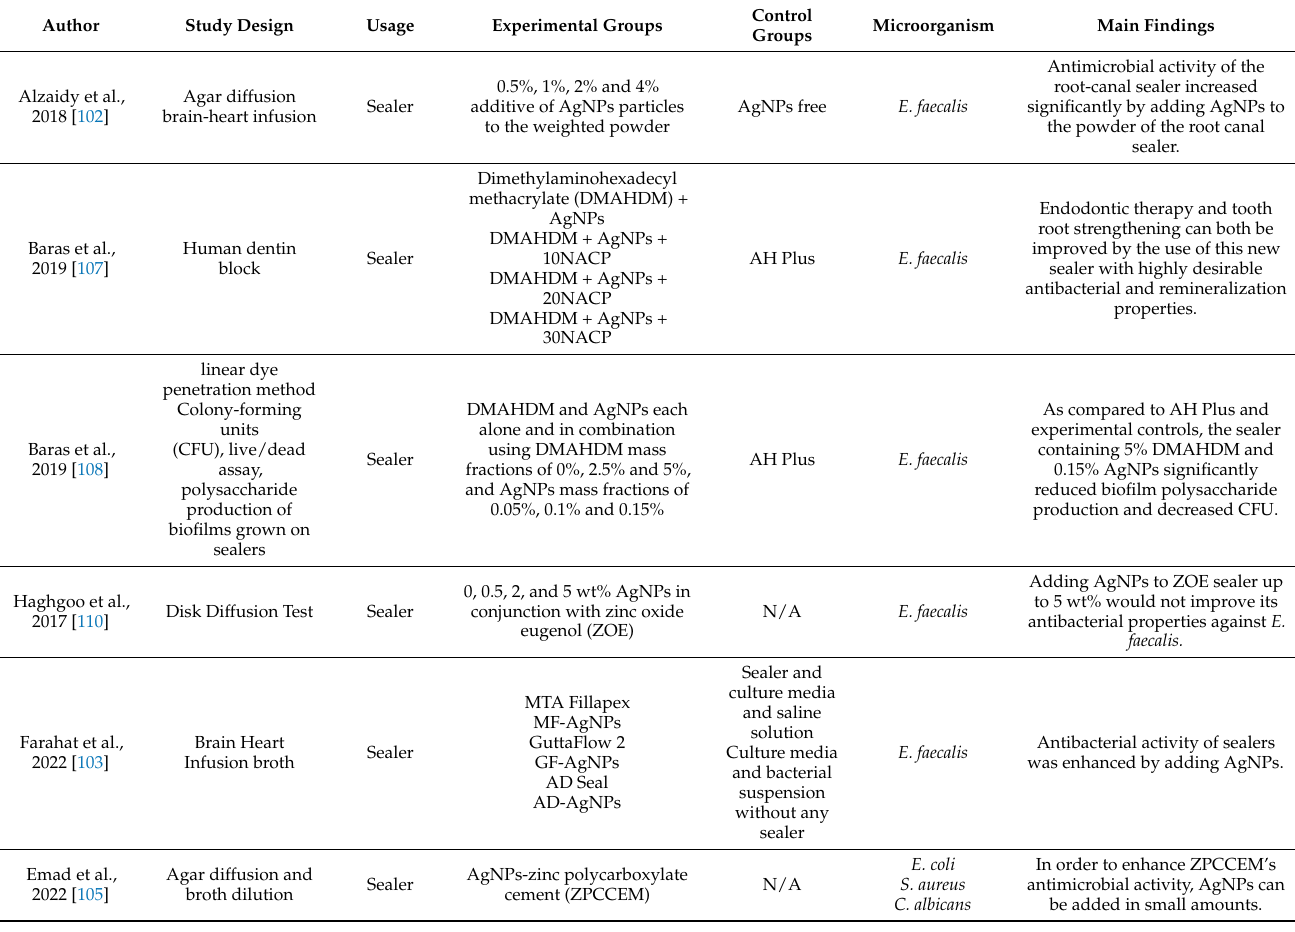
Table 4. Studies of alternative antimicrobial filling materials highlighting antimicrobial type, study design, usage, experimental and control groups, microorganisms tested, and main